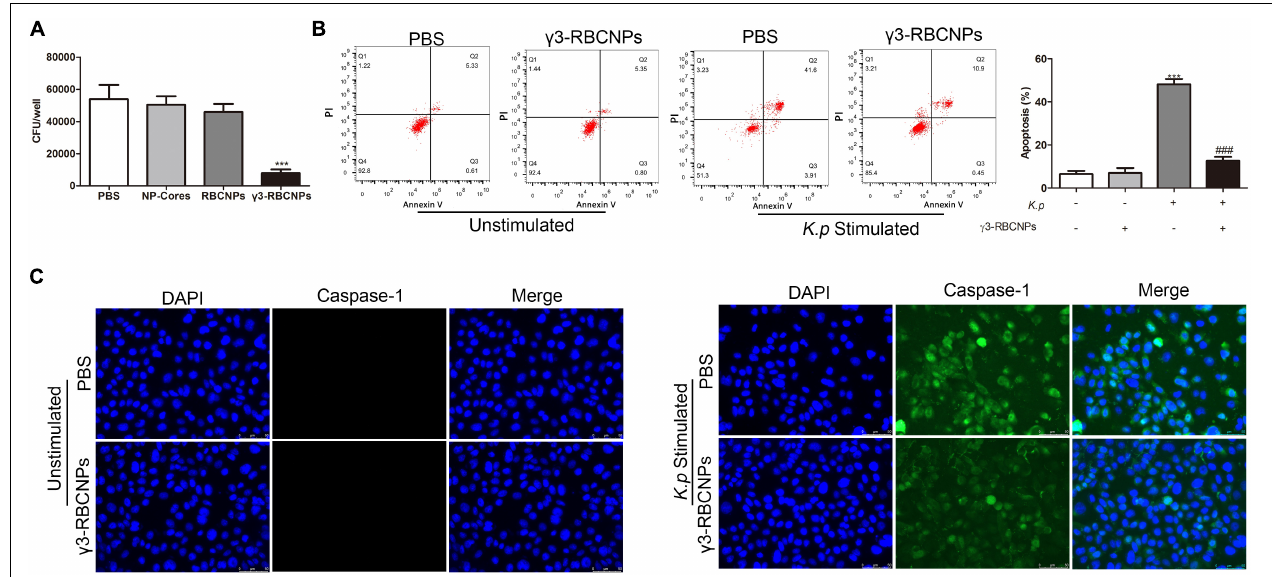
FIGURE 3 | Evaluation of the therapeutic effect of γ 3-RBCNPs in vitro . (A) Quantification of the number of bacteria in HUVECs treated with NP-cores, RBCNPs, and γ 3-RBCNPs after K.P infection. *** P < 0.001 vs. PBS group. Flow cytometry (B) and IF staining (C) detect the apoptosis of HUVECs treated with γ 3-RBCNP after K.P infection. Scale bar = 50 µ m. *** P < 0.001 vs. unstimulated groups. ### P < 0.001 vs. K.P stimulated PBS